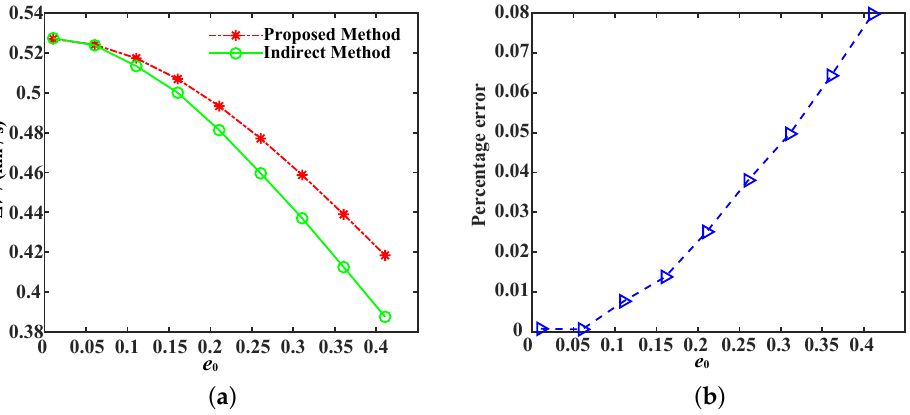
Figure 5. Comparison of ∆ V for example 2. ( a ) ∆ V solved by the two methods. ( b ) Percentage error of the estimation of ∆ V